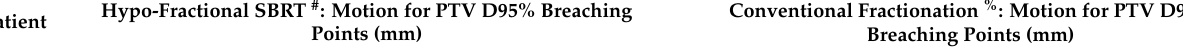
Table 3. The two PTV D95% breaching points (D95% = 95% and D95% = 90%) with increased motion amplitude (in mm) are shown based on quadratic fittings (with R 2 values). For small tumors (Patients 2, 8, and 9 with GTV < 25 cm 3 ), only 2–5 mm and 4–8 mm can lead D95% decrease to 95% and 90%, respectively. For larger tumors (patients 1, 3, 4, 5, 6, 7, and 10 with GTV > 25 cm 3 ), however, 9–17 mm and 16–31 mm additional motions are needed to decrease D95% to 95% and 90%, respectively.